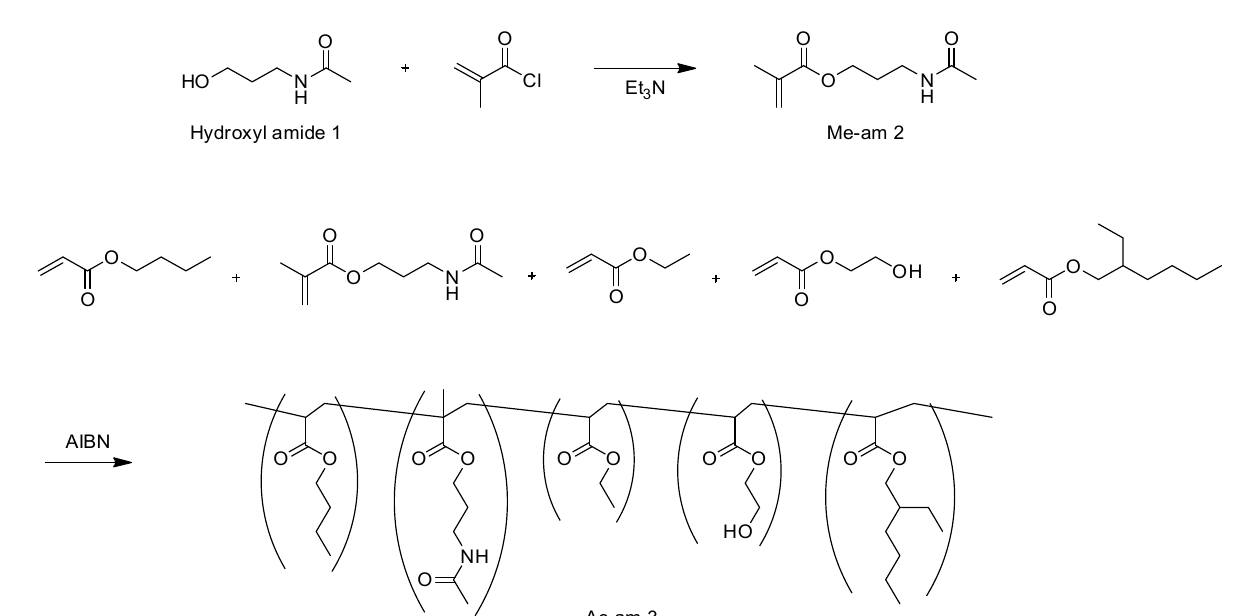
Scheme 1. Synthesis of Me-am 2 and Ac-am 3.